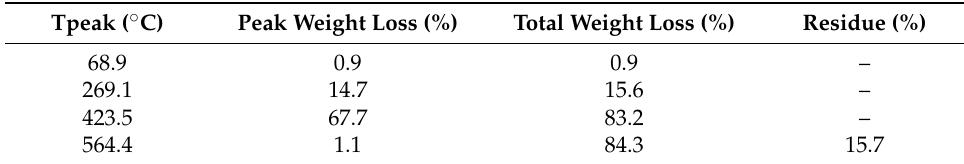
Table 4. Thermal parameters for sample